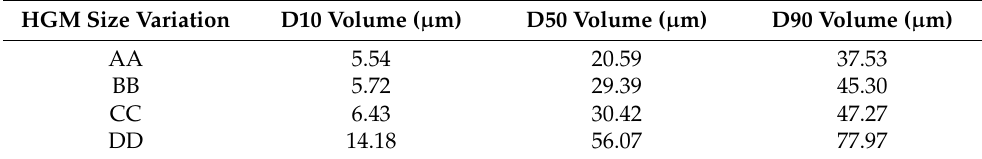
Table 1. Particle size distribution of HGM to measure the particle diameter of the size ranges.